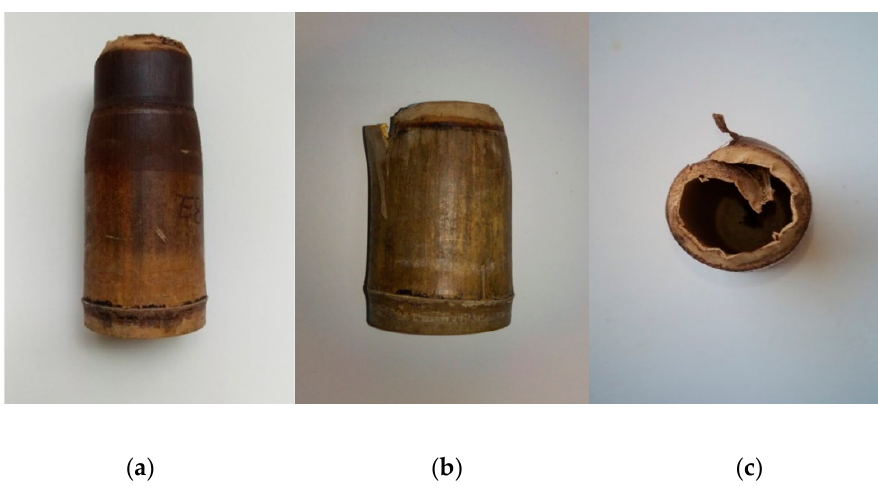
Figure 4. The number of successes and failures of various bamboo and heating methods.